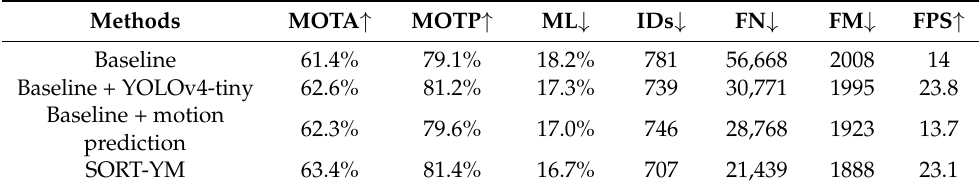
Table 3. The ablation experiments on the MOT-16